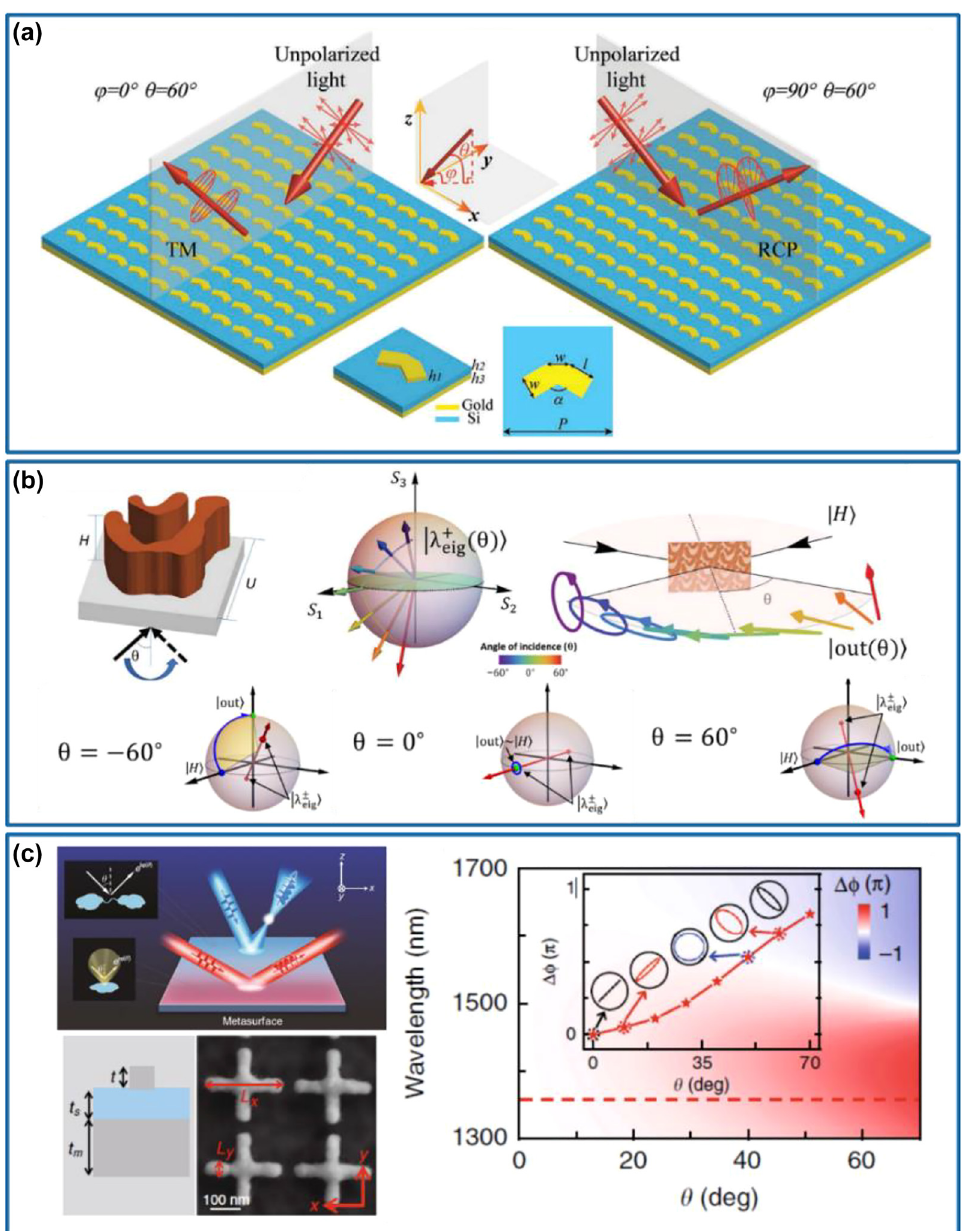
Figure 7: Angle-multiplexed multifunctional meta-waveplates. (a) Schematic of the dual-functional meta-waveplate: for an unpolarized incident wave with 0 ° azimuthal angle and 60 ° elevation angle, its TE-polarized component will be totally absorbed and an LP wave with TM polarization can be obtained, while the re fl ected wave becomes RCP, and the LCP component is absorbed for the incident light with 90 ° azimuthal angle and 60 ° elevation angle. The inset shows the 3D and top view of the unit cell. Reprinted from Ref. [110]. (b) Top panel: schematic of the optimized structure and angle-dependent polarization generation. Bottom panel: polarization space representation of the device functionality at different angles. Reprinted from Ref. [111]. (c) Left panel: physical origins of angular dispersions and schematics of the angle-dependent multifunctional meta-device. Right panel: simulated re fl ection-phase difference between orthogonal linear polarizations versus wavelength and incident angle. The inset shows the re fl ection phase difference and corresponding polarization states as a function of the incident angle at λ = 1358 nm. Reprinted from Ref.